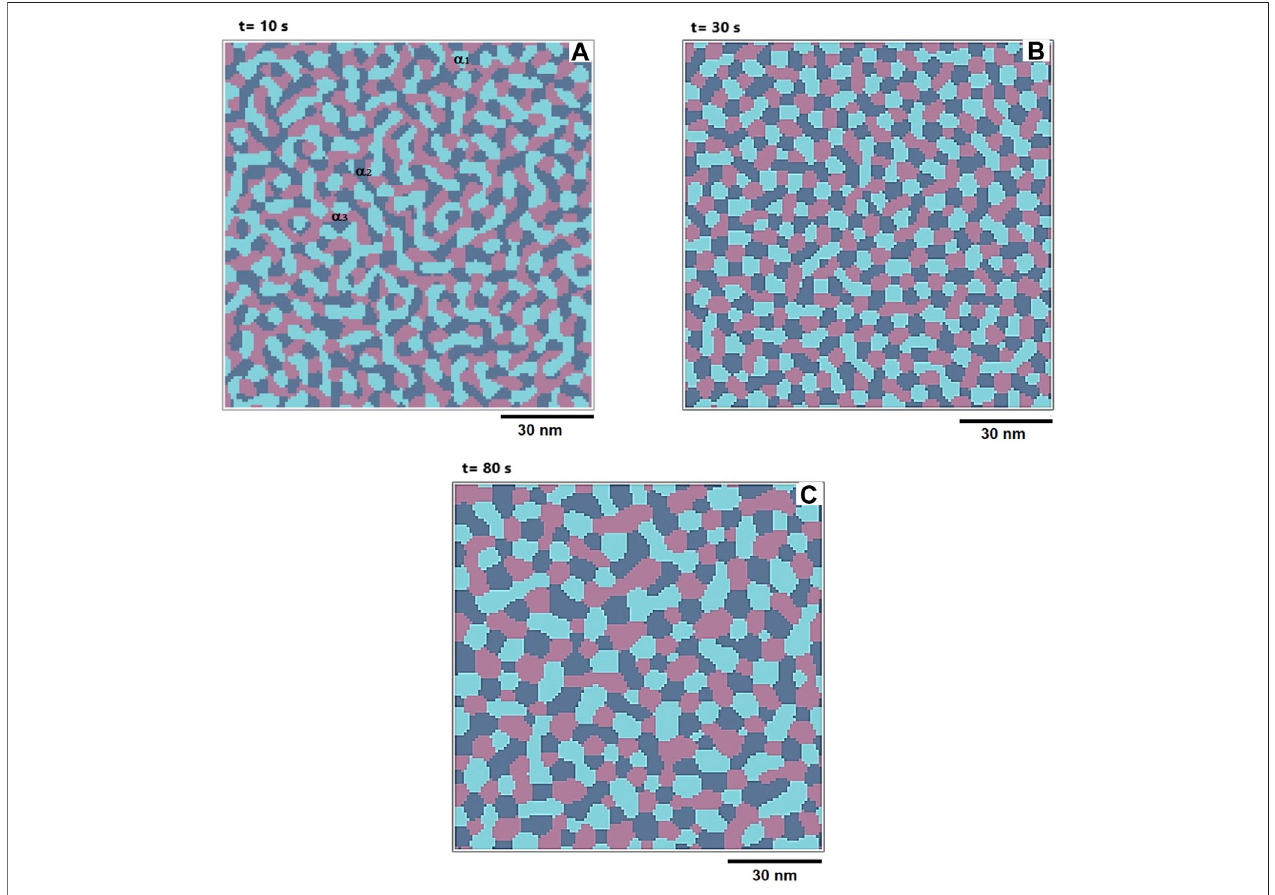
FIGURE 6 | Simulated microstructure of the A – B – C alloy for case I with X A =X B = X c = ⅓ aged at 800 K for (A) 10 s, (B) 30 s, and (C) 80 s.